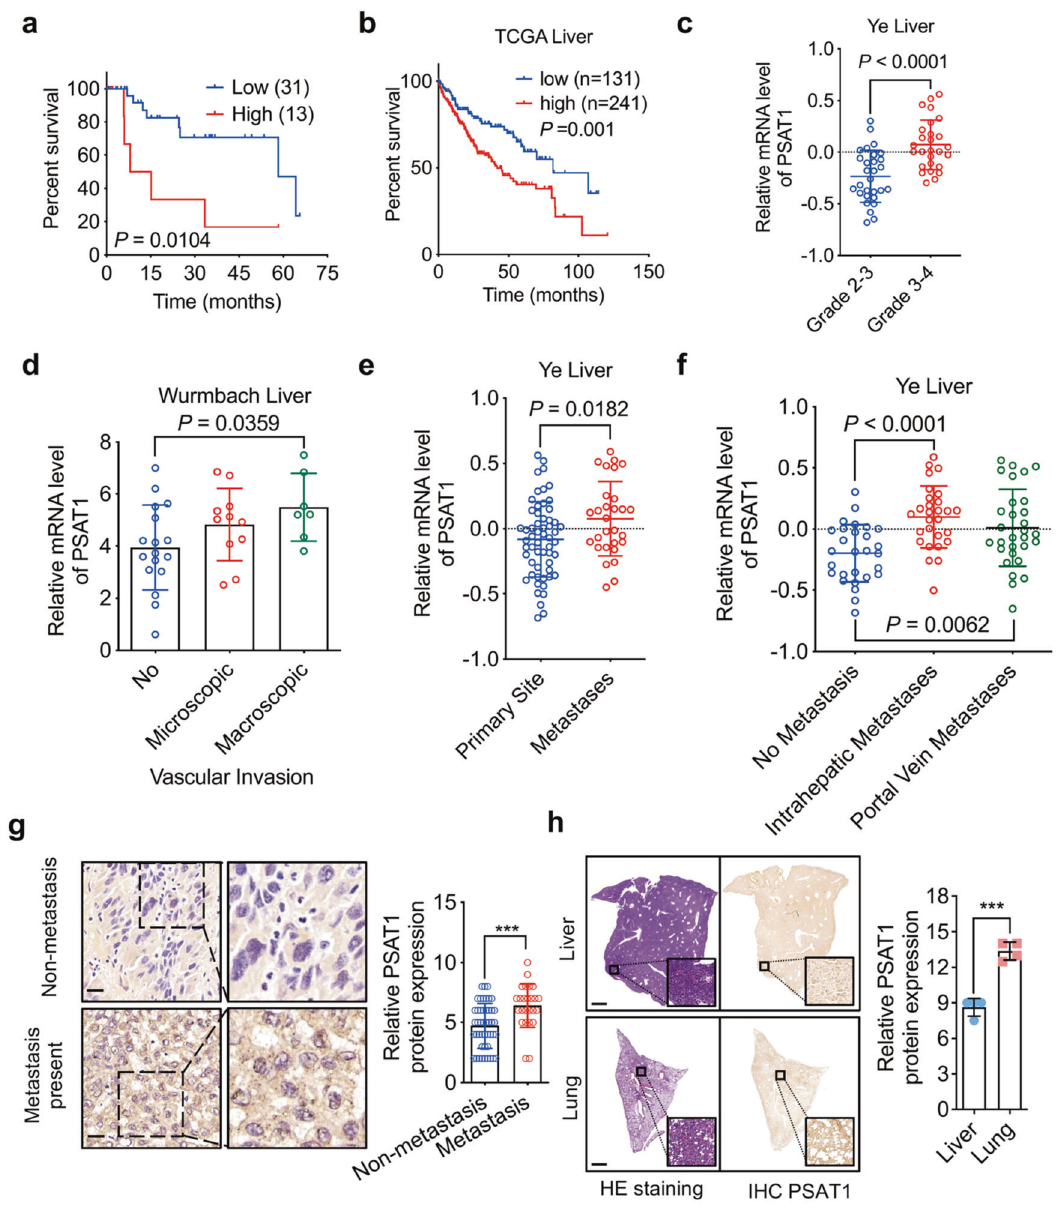
Fig. 2 PSAT1 is up-regulated in human metastatic HCC tissues and predicts poor prognosis. a , b Kaplan-Meier analysis of overall survival rate based on PSAT1 expression in HCC samples and TCGA-Liver dataset. c PSAT1 mRNA levels in different grades of HCC patients according to Oncomine data set Ye Liver. d PSAT1 mRNA levels in HCC patients with or without vascular invasion according to Oncomine dataset Wurmbach Liver. e PSAT1 mRNA levels in primary or metastatic tumor tissues according to Oncomine dataset Ye Liver. f PSAT1 mRNA levels in HCC tissues with or without metastases according to Oncomine dataset Ye Liver. g IHC analysis of PSAT1 protein level in HCC tissue samples with ( n = 26) or without ( n = 46) intrahepatic metastasis. Scale bar, 20 μ m. Data are means ± s.d. *** P < 0.001. h HE and IHC analysis of PSAT1 protein level in mice liver and lung (intrahepatical mice model). Scale bar, 1000 μ m. Data are means ± s.d. *** P < expression of EMT markers. PSAT1 knockout or knockdown PSAT1 depletion impedes the metastatic potential of tumor cells signi fi cantly decreased mesenchymal markers such as ZEB1 in containing p53-72Pro variants cells expressing p53 72P variants (Fig. 3b and Supplementary Fig. To elucidate the function of PSAT1 in regulating the metastasis of cells expressing different p53 72 variants, PSAT1 was knockout in Hep3B cells. Loss of PSAT1 was shown to inhibit the metastasis of Hep3B cells containing the p53 72P variant but not in those expressing vector or p53 72R variant, indicating that PSAT1 plays an obligatory role in the migration and invasion of cells containing the p53 72P variant (Fig. 3a). Given that epithelial-to-mesenchymal transition (EMT) is essential for elevated cell mobility and invasion, we then investigated the effect of PSAT1 knockdown on the